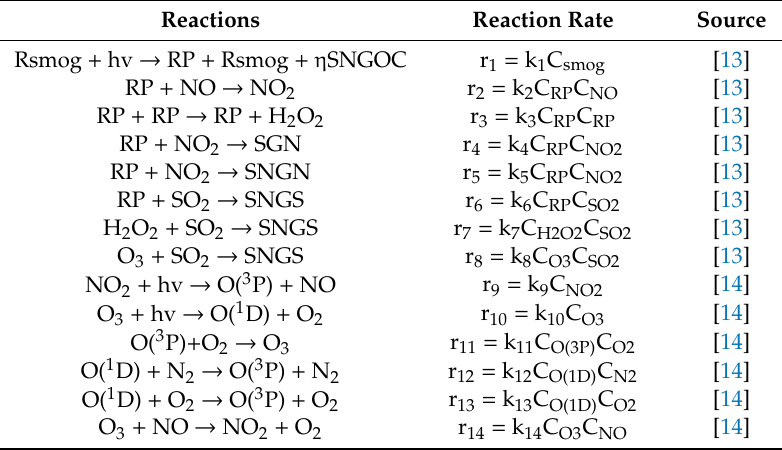
Table 1. Chemical reactions of the modified GRS kinetic